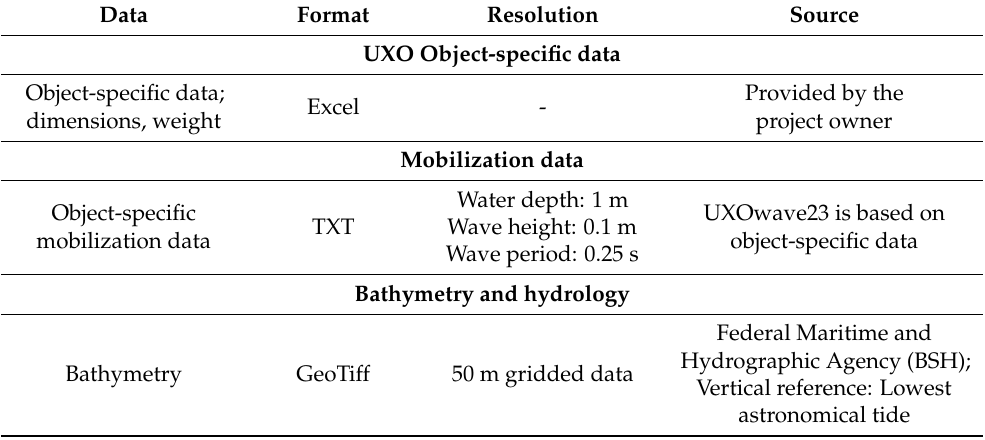
Table 2. List of input data